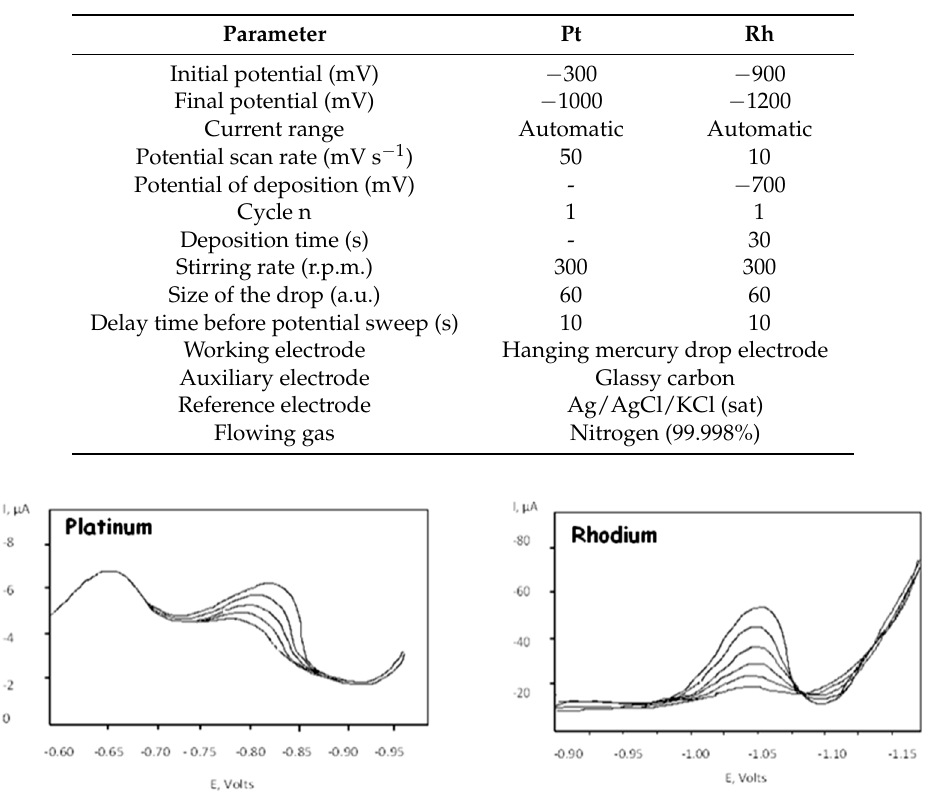
Table 2. Operating parameters for the differential pulse voltammetry and adsorptive stripping voltammetry analysis of the solutions obtained from the potato samples.